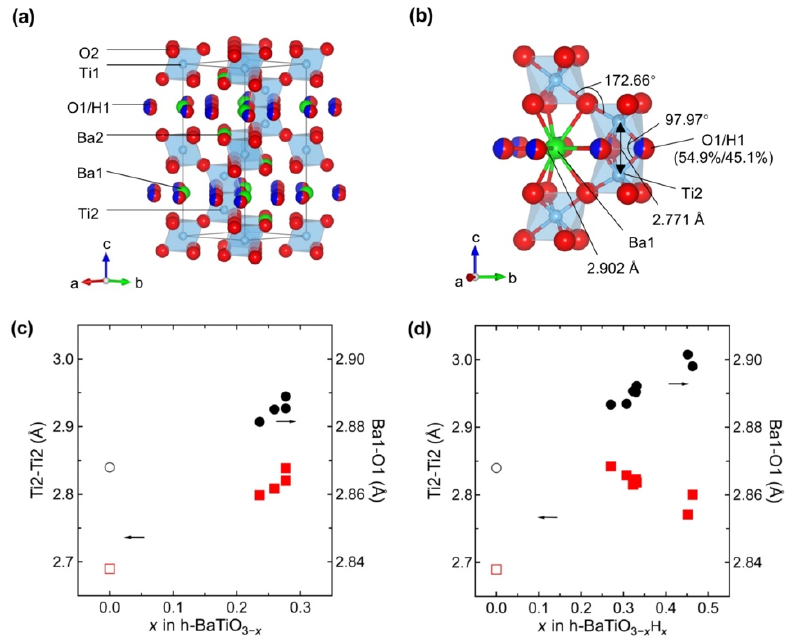
Figure 9. ( a ) Crystal structure of 6H-BaTiO 3 − x H x , where green, white, red, and blue spheres represent Ba, Ti, O, and H atoms, respectively. ( b ) Local geometry around Ba and Ti cations for BaTiO 2.55 H 0.45 . Interatomic distances of Ti2–Ti2 and Ba1–O1 as a function of oxygen deficiency x for ( c ) 6H-BaTiO 3 − x and hydride content for ( d ) 6H-BaTiO 3 − x H x . The values of x = 0 (after Akimoto [28]) are shown in open symbols for comparison. The errors are within the size of the symbols.